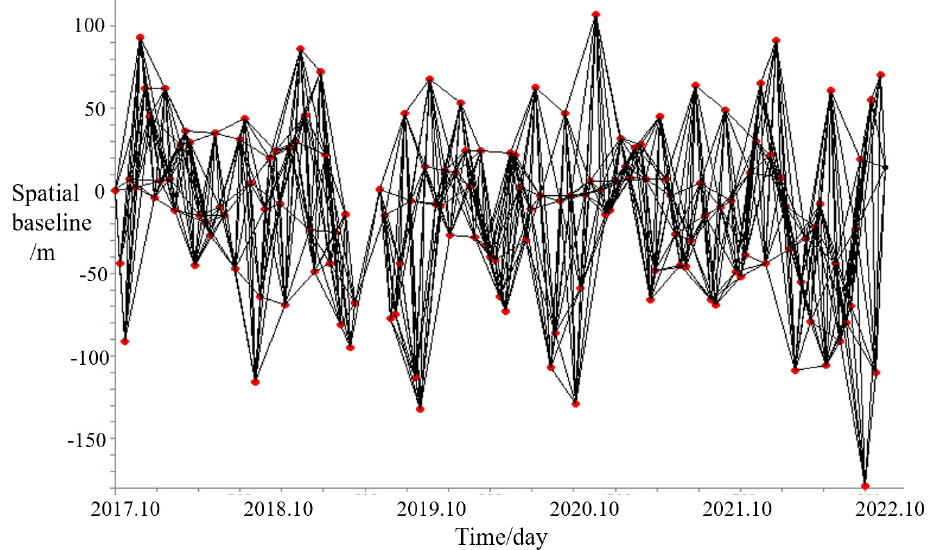
Figure 5. Spatiotemporal baseline of the Sentinel images with track 26 − 2.